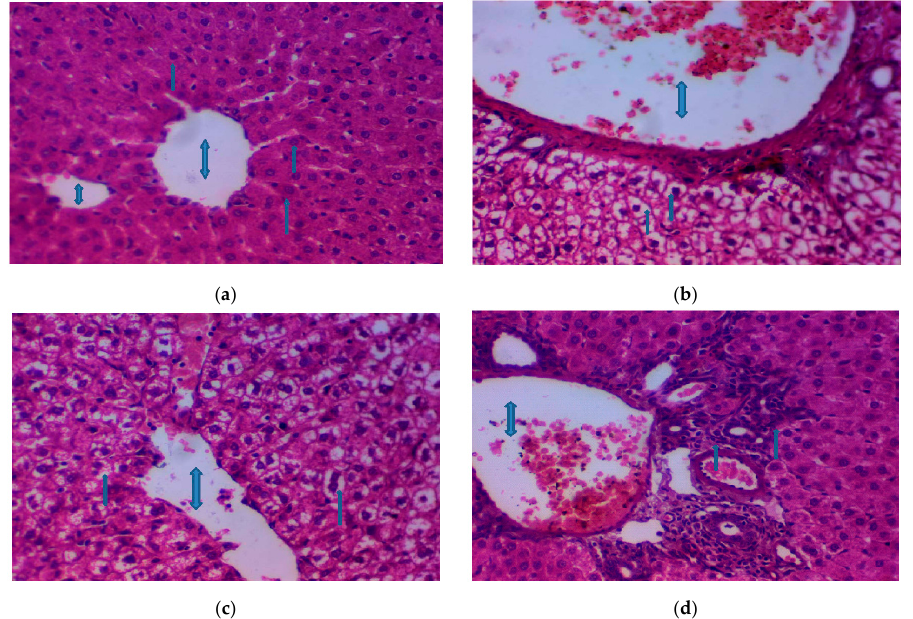
Figure 8. Histology of the liver. Liver tissue was collected from each animal after 30 days of treatment. The tissue was sectioned, stained using H & E, and imaged using standard light microscopy at 400× magnifications. Double-sided arrow ( ↕ ) denotes the central vein and single-sided arrows ( ↑ ) indicate aggregates of inflammatory cells. ( a ) Liver from healthy control animal (Group I); ( b ) Liver from STZ-treated diabetic animal (Group II); ( c ) Liver from animal treated with oxidovanadium(IV) sulfate alone (Group III); ( d ) Liver from animal treated with the oxidovanadium(IV)–AMP complex (Group IV).